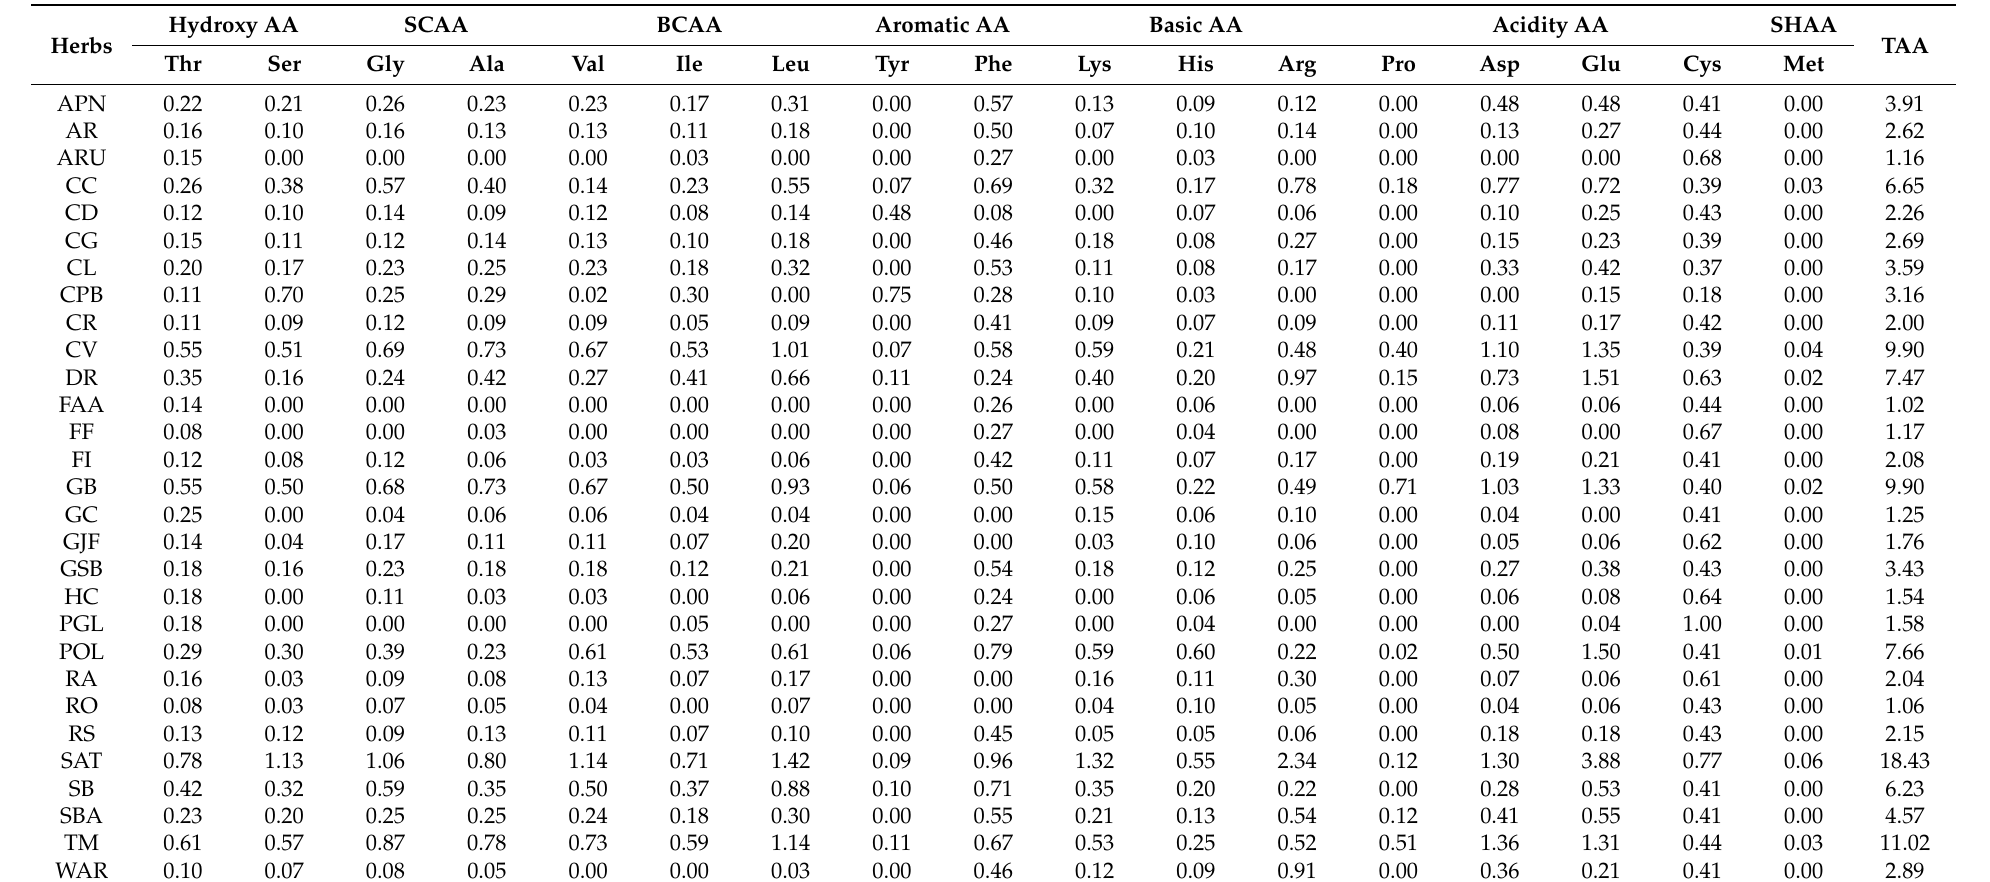
Table 3. Amino acids (AAs) contents of 29 different Chinese herbs